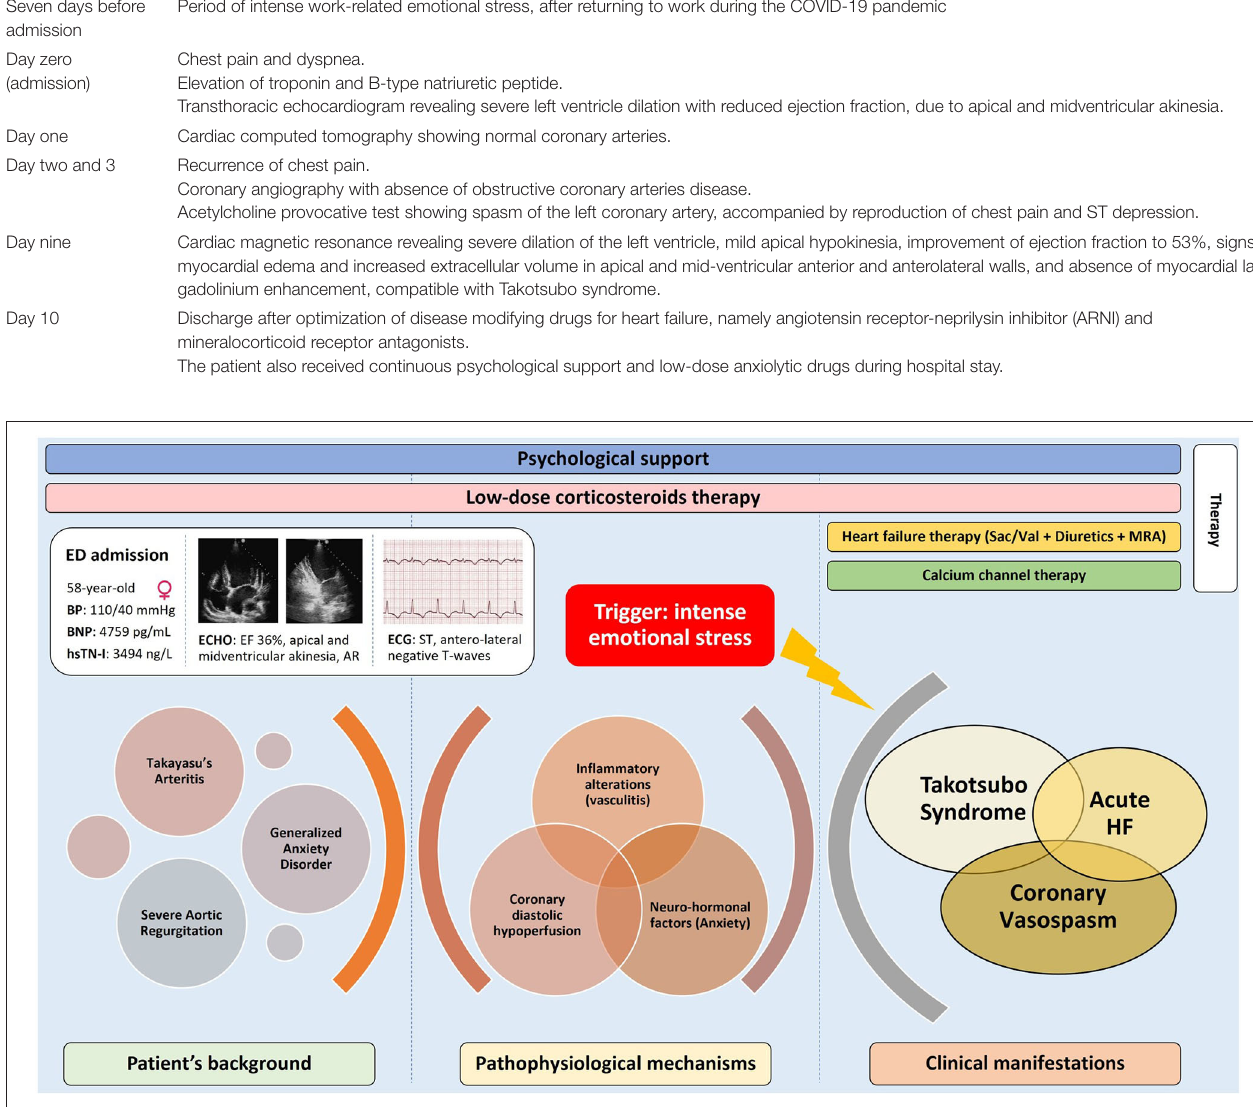
FIGURE 4 | Central illustration showing the complex interplay between patient background conditions (Takayasu’s, aortic regurgitation and generalized anxiety disorder), underlying pathophysiological mechanisms and clinical manifestations, including acute heart failure, Takostubo syndrome and coronary vasospasm, triggered by an intense emotional stress. The clinical presentation, main complementary exams and the therapy during admission are